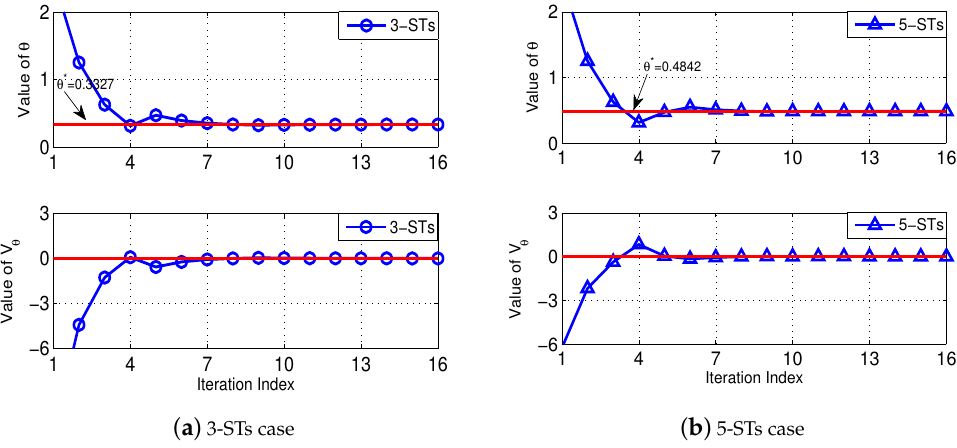
Figure 3. Illustration of the operations of Algorithm 2.